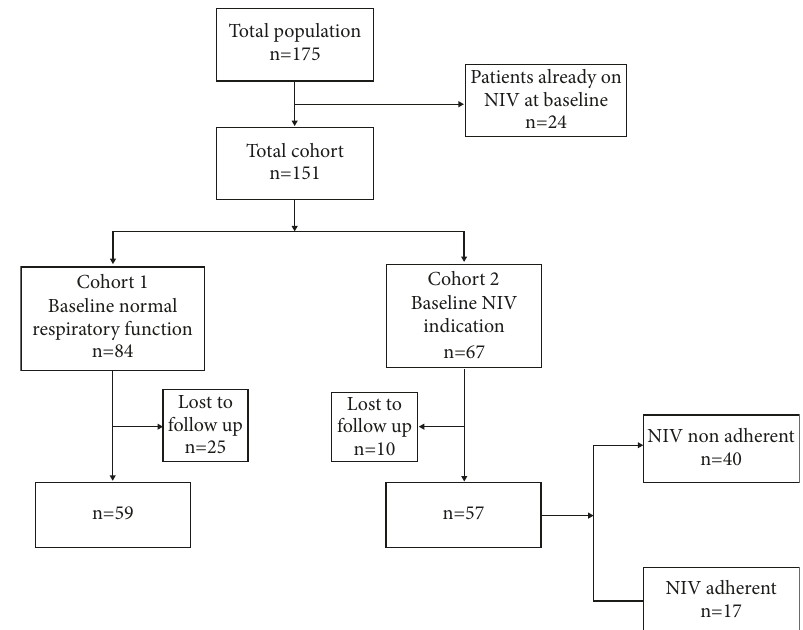
Figure 1: Respiratory follow-up of the 2